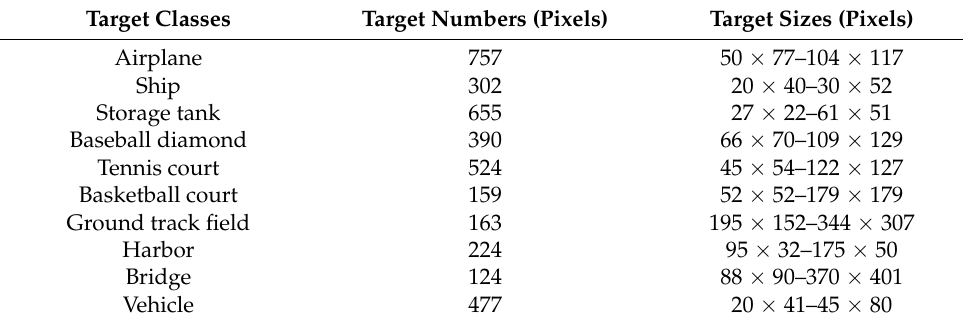
Table 1. A detailed introduction to NWPU VHR-10 dataset.